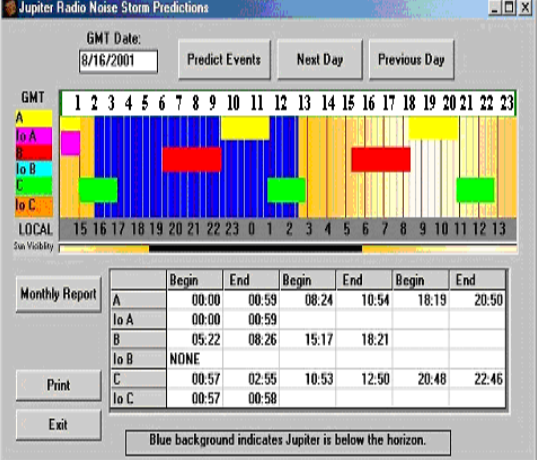
Fig.3: Radio noise storm prediction screen of radio Jupiter